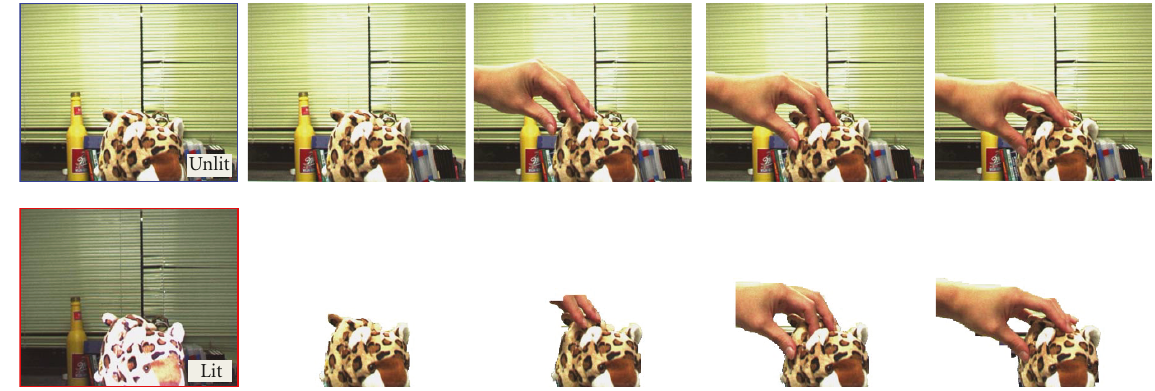
Figure 15: Segmentation of the “Tiger” sequence by the proposed algorithm II. The leftmost column shows a pair of unlit and lit frames, while the other columns show a series of unlit frames and their segmentation results.